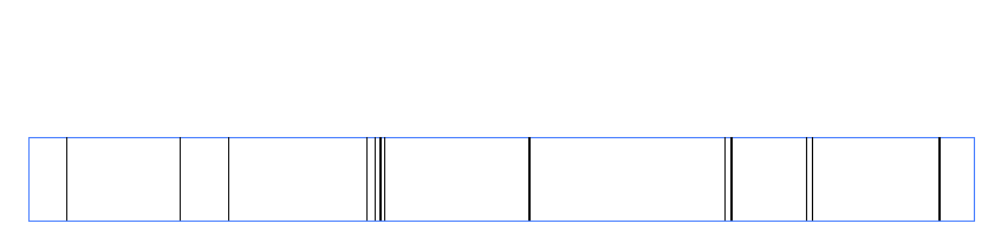
Fig. 1. The frequency of use of the concept ‘chance’ (Developed by the author using AntConc ).